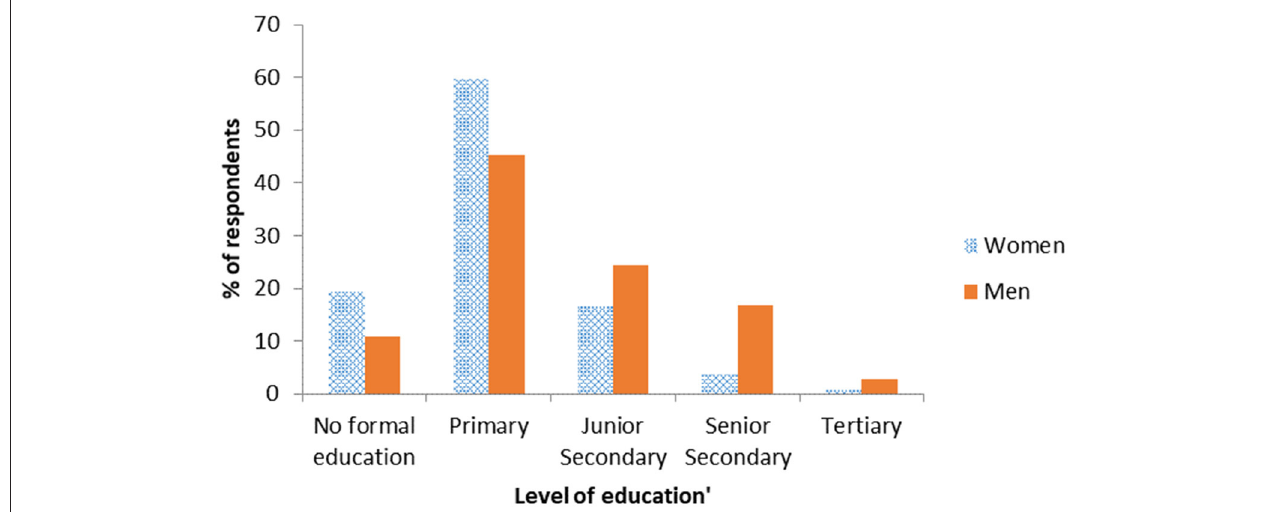
FIGURE 2 | Educational attainment of household heads and their